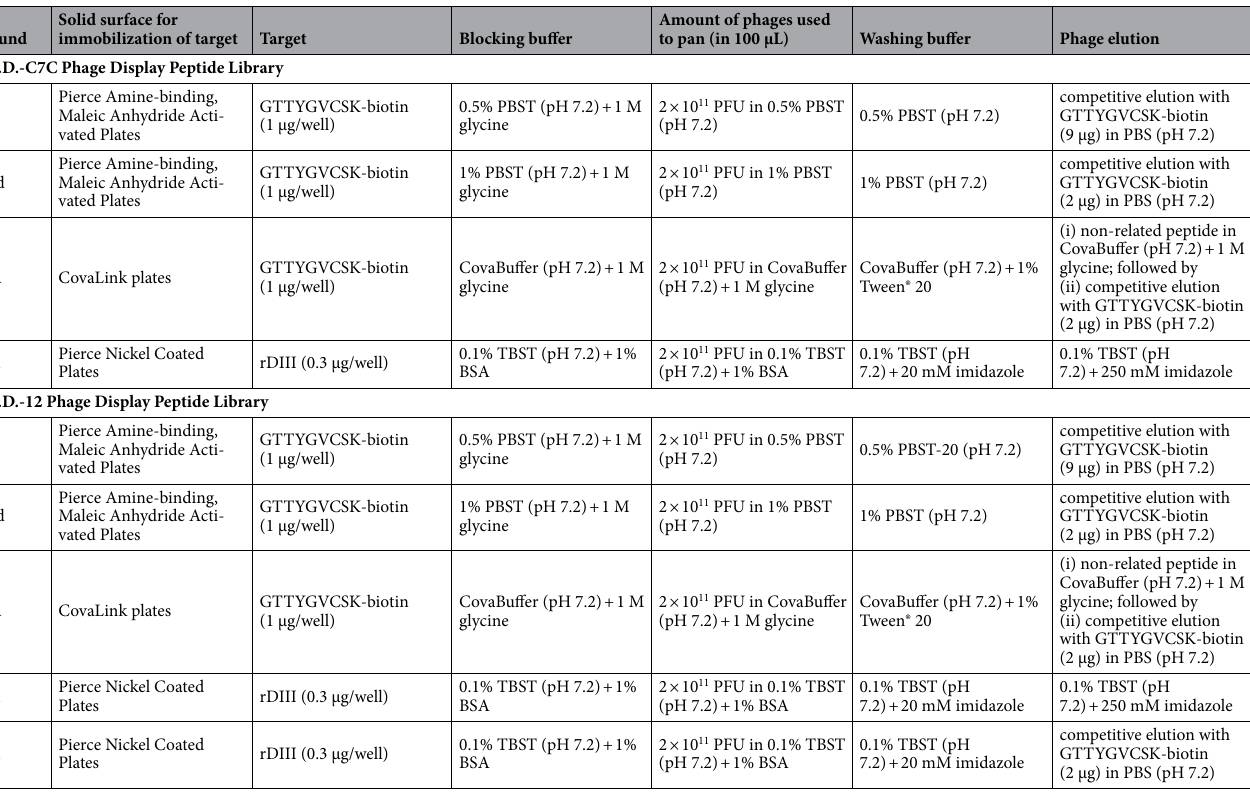
Table 1. Description of each round of panning performed with Ph.D.-C7C and Ph.D.-12 Phage Display Peptide Library. CovaBuffer (2 M NaCl, 40 mM MgSO4.7H2O, 0.05% Tween® 20 in PBS).